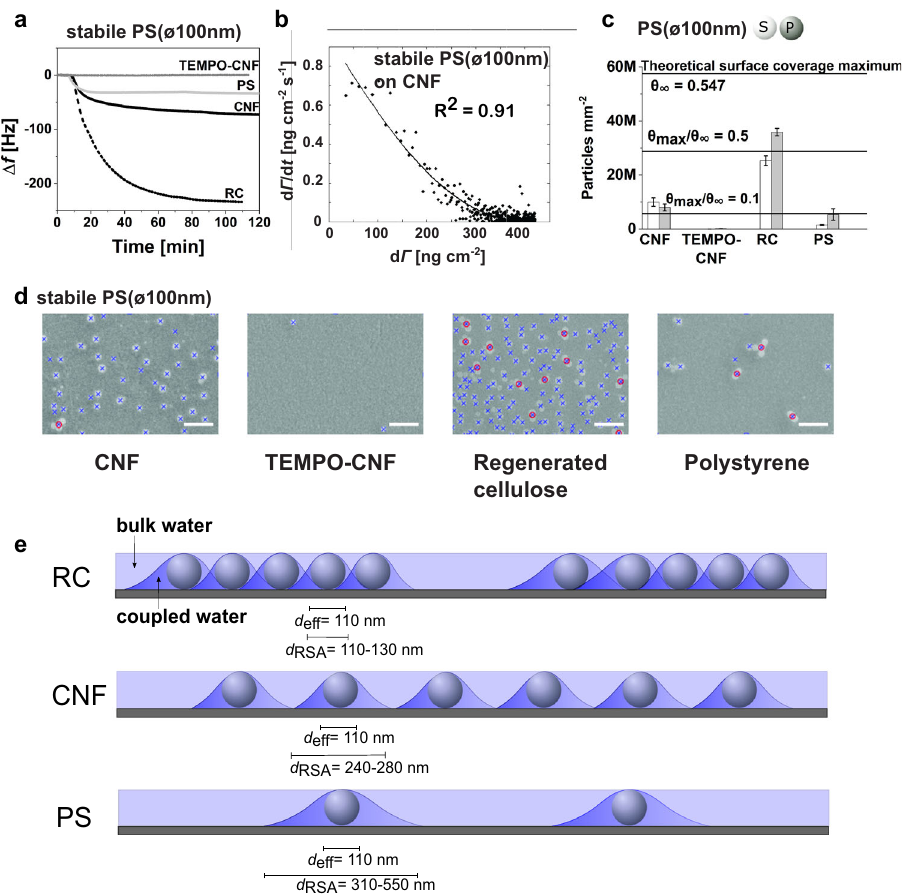
Fig. 3 Quantitative assessment of surface binding of nanoplastic polystyrene (PS) particles (stabile/puri fi ed PS(ø100 nm)) using a surface-sensitive approach, quartz crystal microbalance with dissipation monitoring (QCM-D), coupled with image analysis and fi ttings with random sequential adsorption (RSA) model. a QCM-D frequency change responses showing the adsorption of stabile PS(ø100 nm) on TEMPO-CNF (dark gray line), PS (gray line), native CNF (solid black line), and RC (dashed black line). b Fitting of the QCM-D adsorption data of stabile PS(100 nm) on CNF using the RSA model. Black dots are measured data, and black line is the RSA fi t. The adjusted R 2 for the fi t is 0.91. c Amount of PS(ø100 nm) detected after the adsorption experiments (white bars stabile, gray bars puri fi ed) via image analysis of SEM micrographs contrasted to a theoretical surface coverage maximum ( θ ∞ = 0.547 which equals to ~5.8 × 10 − 7 circles mm − 2 ), which is based on the RSA model. Error bars indicate mean ± SD. d Stabile PS(ø100 nm) recognition from scanning electron microscopy (SEM) images using image analysis (Supplementary Fig 12). Blue crosses indicate single particles and red circles indicate identi fi cation of clusters. The SEM image scale bar is 0.5 µ m. e Schematic presentations display the appearance of substrates at the end of the PS(ø100 nm) adsorption process showing the existence of bulk water and water which is strongly interacting with the particles. d eff describes the effective particle diameter, and d RSA is the diameter of the occupied area ( a ) of a single particle including the particle and the coupled water. Source data are provided as a Source Data fi